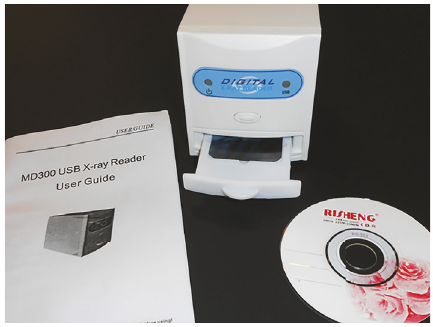
Figure 1: MD300 USB X-ray